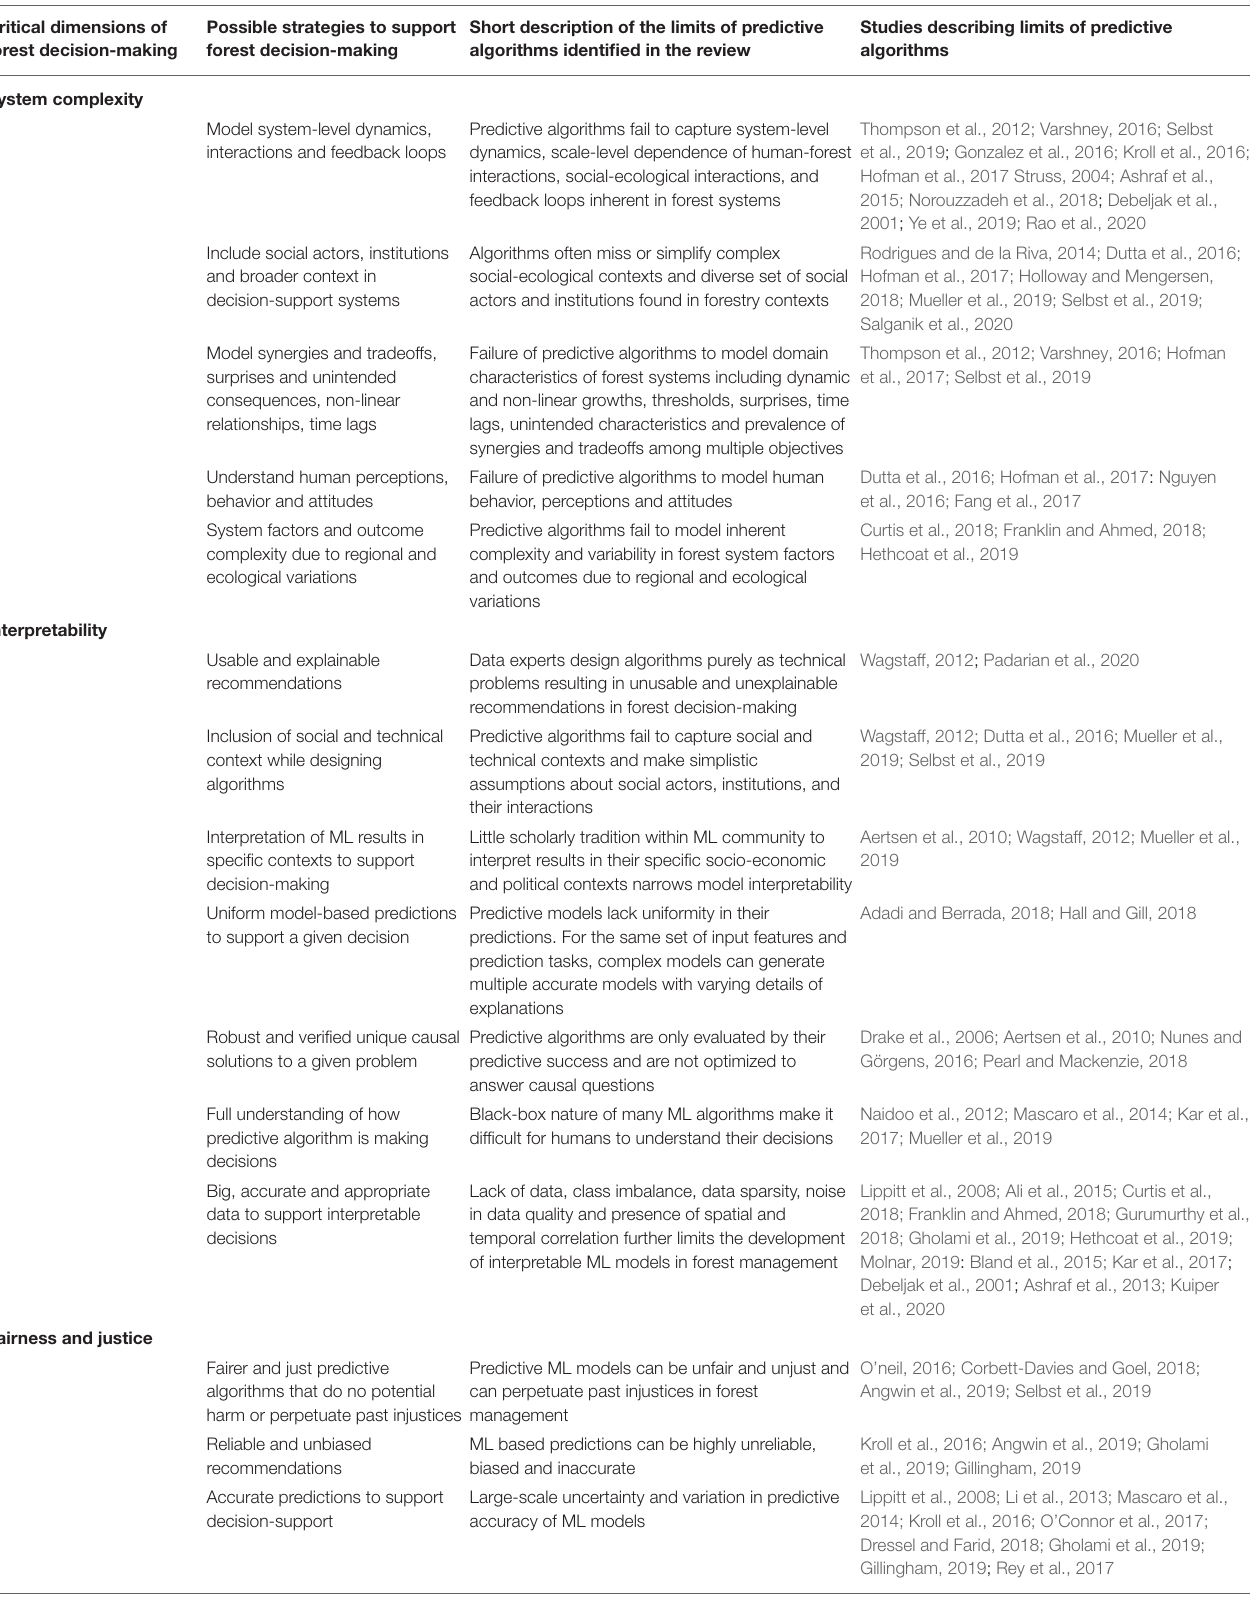
TABLE 2 | Critical dimensions of forest decision-making, possible strategies and limits of predictive algorithms to support these strategies. Critical dimensions of forest